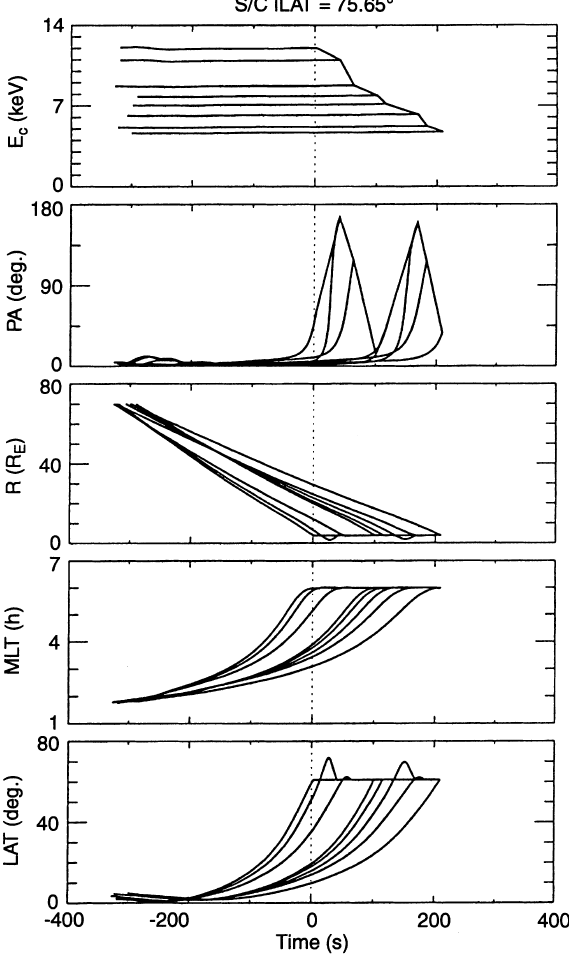
Fig. 13. Same presentation as Fig. 9 for the energy-pitch angle ion dispersion observed at 00:37 ( T = 0) to 00:39:30 UT on 28 September 1996 (see Figs. 10 and 11) Fig. 13 for the ion dispersion first appearing at 00:37